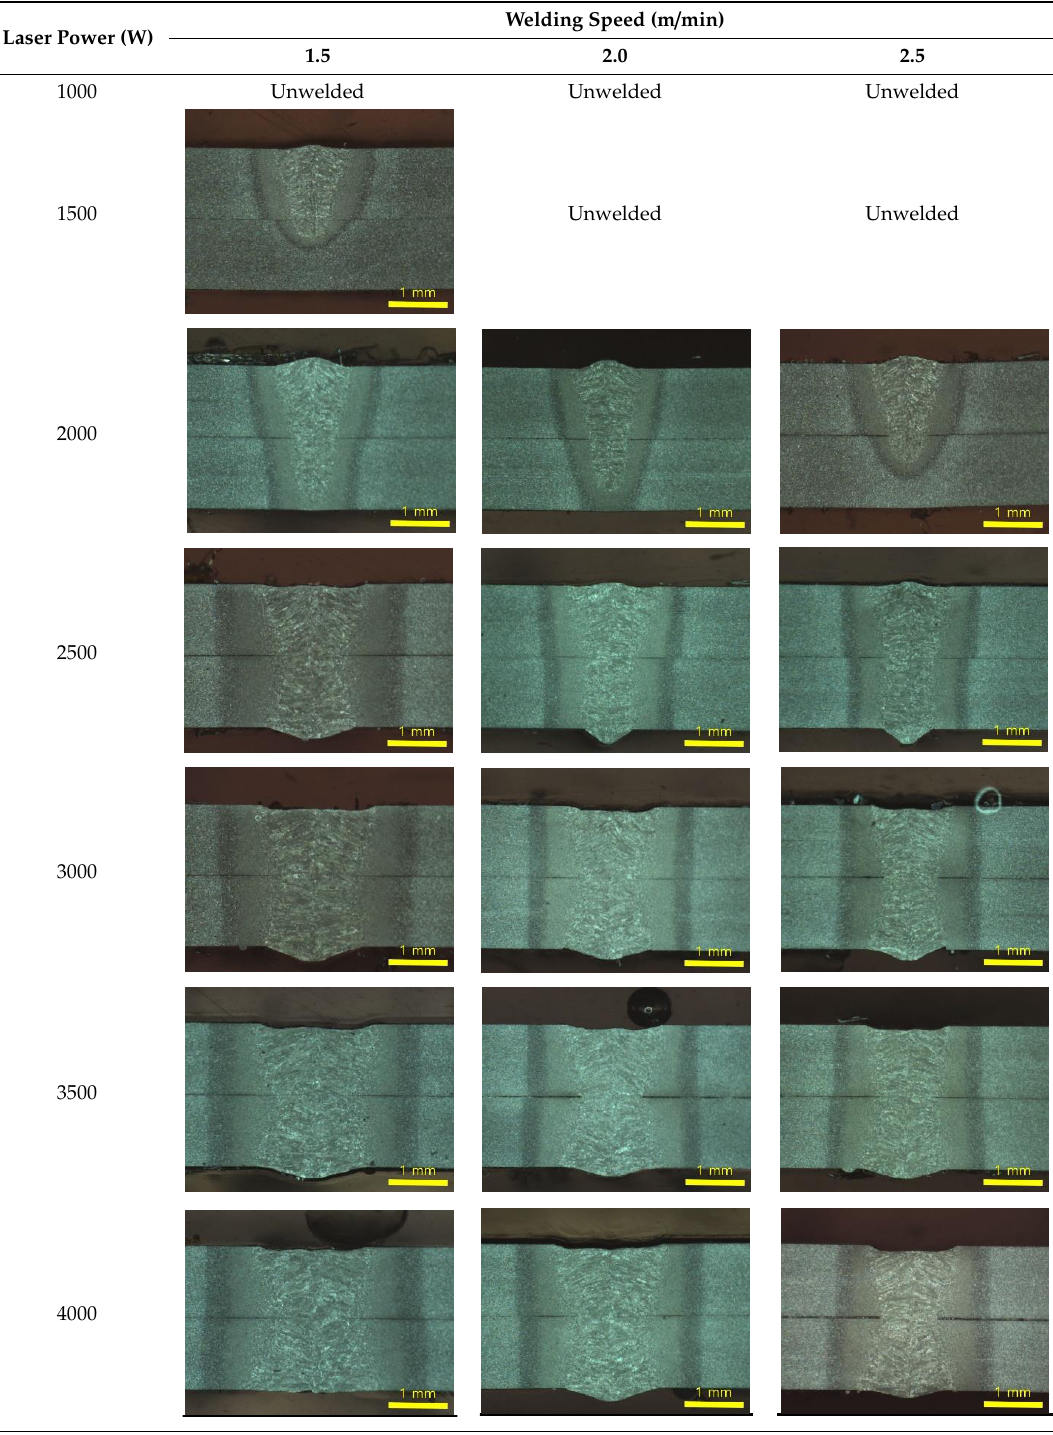
Table 2. Cross-sections of welded joint according to the laser power and welding speed.